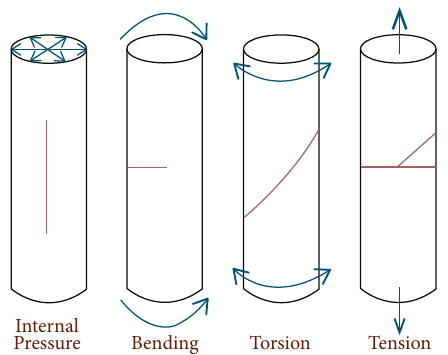
Figure 2: Fracture planes caused by general fatigue forces.